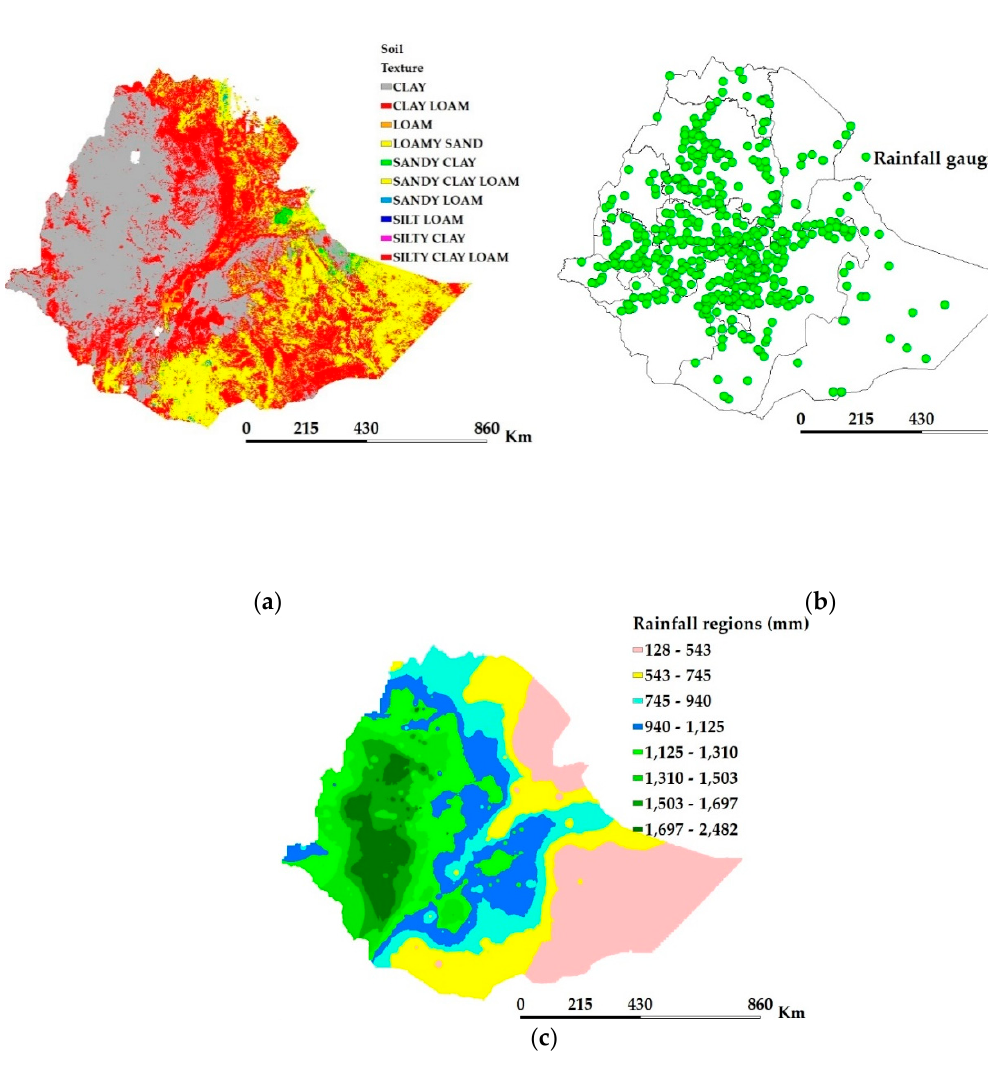
Figure 6. Soil textures ( a ), locations of rainfall gauging stations ( b ), and rainfall regions regimes ( c ).